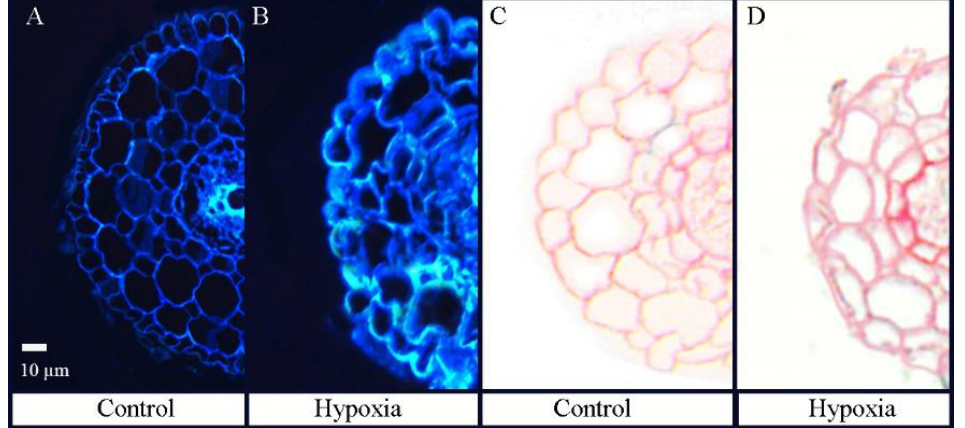
Figure 4. Cross sections of distal root segments in control B. napus plants ( A , C ) and in plants treated for three days with root hypoxia ( B , D ). Lignin autofluorescence was visualized following UV irradiation ( A , B ). Suberin deposition stained with Sudan 7B was visualized with light microscopy ( C , D ). Table 1. Summary of RNA-Seq performed for Brassica napus root distal segments after three days of